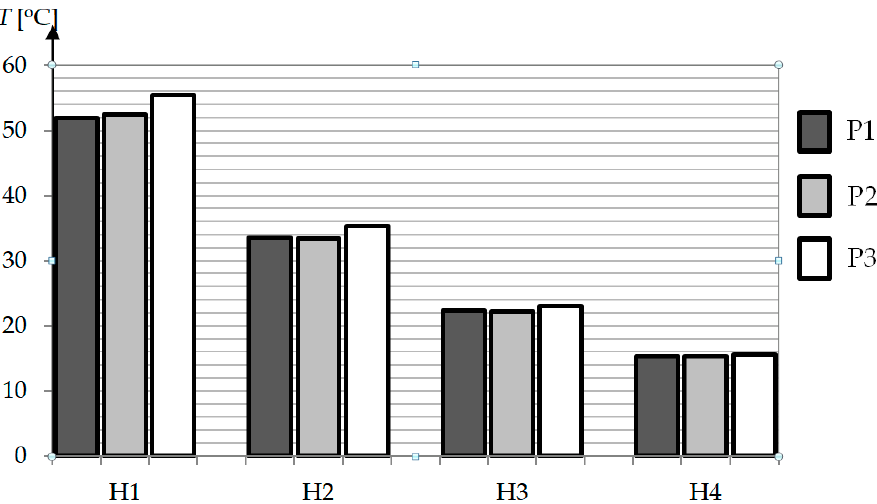
Figure 9. The temperature difference between points A and C for different geometries and distances between mold and inductor after t = 10